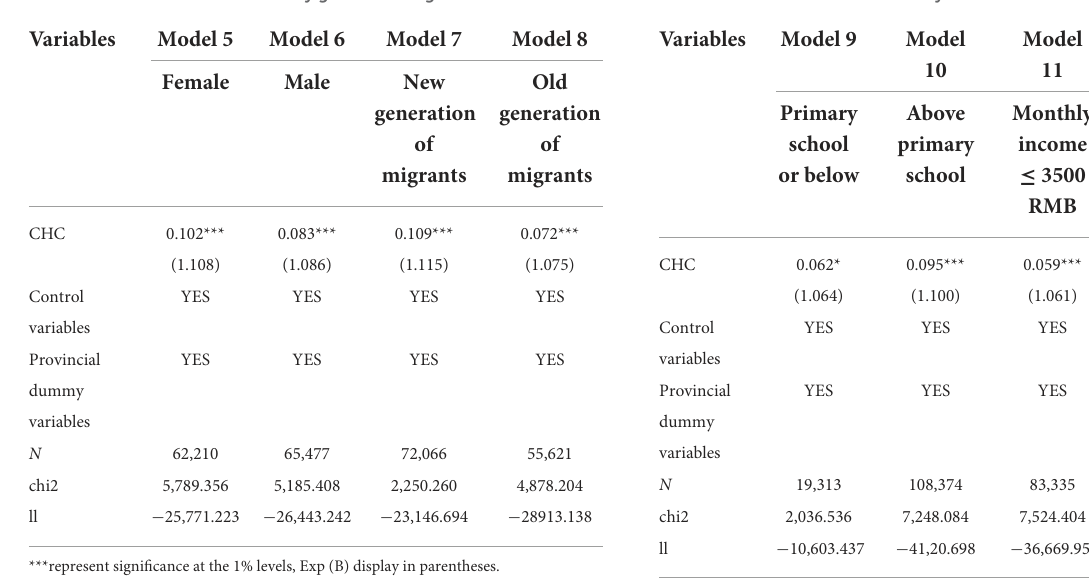
TABLE 5 Effect of CHCs on SRH by gender and age. TABLE 6 Effect of CHCs on SRH by education and monthly